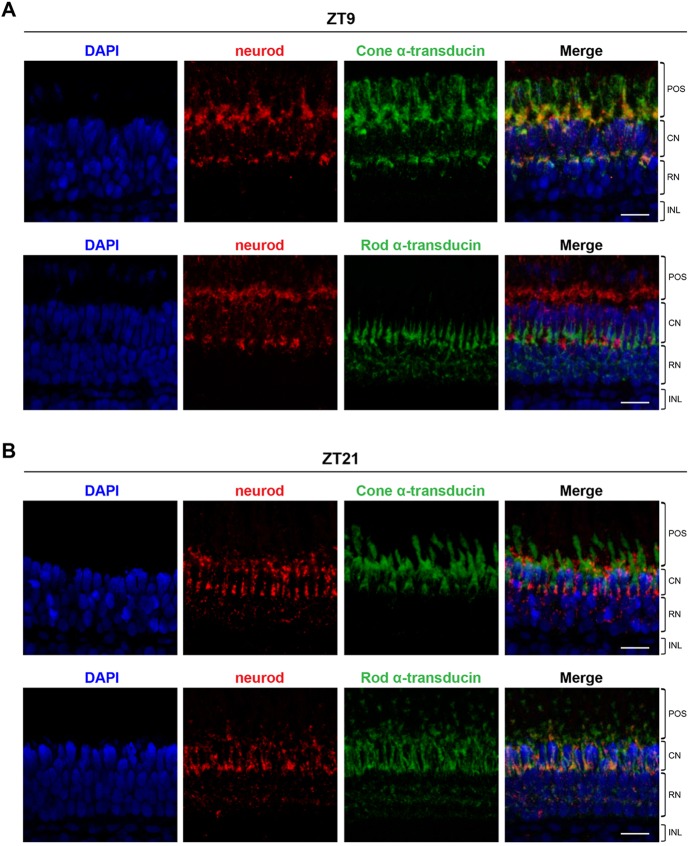
Dynamic expression of neurod in zebrafish adult photoreceptors. Representative maximum projection confocal images of double fluorescent in situ hybridisation for neurod and cone α-transducin (gnat2) or neurod and rod α-transducin (gnat1) on adult eye sections at ZT9 (A) and ZT21 (B). DAPI was used as a nuclear counterstain. POS, photoreceptor outer segments; CN, cone nuclei; RN, rod nuclei; INL, inner nuclear layer. Scale bars: 15 µm.